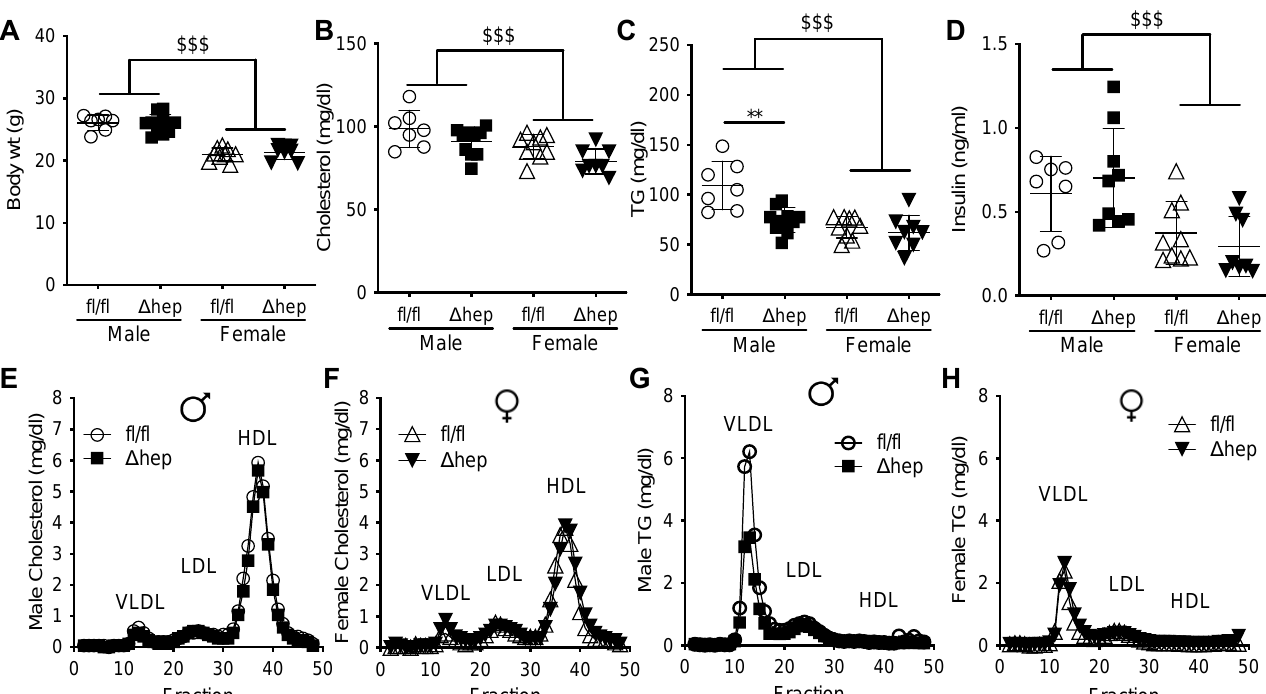
Figure 1. Effect of hepatic deletion of SHP on plasma lipids. ( A ) Body weight of male and female SHP fl/fl and SHP ∆ hep littermates. ( B – D ) Plasma cholesterol ( B ), TG ( C ), and insulin ( D ) of ad lib fed SHP fl/fl and SHP ∆ hep males and females. ( E – H ) FPLC separation of pooled plasma lipoproteins. Cholesterol content of lipoproteins in male ( E ) and female ( F ) SHP fl/fl and SHP ∆ hep littermates. TG content of lipoproteins in male ( G ) and female ( H ) SHP fl/fl and SHP ∆ hep littermates. Data shown are mean ± SD, n = 7–9/group, ** p < 0.01 for genotype difference, $$$ p < 0.001 for sex effect (2-way ANOVA with post-hoc comparisons).